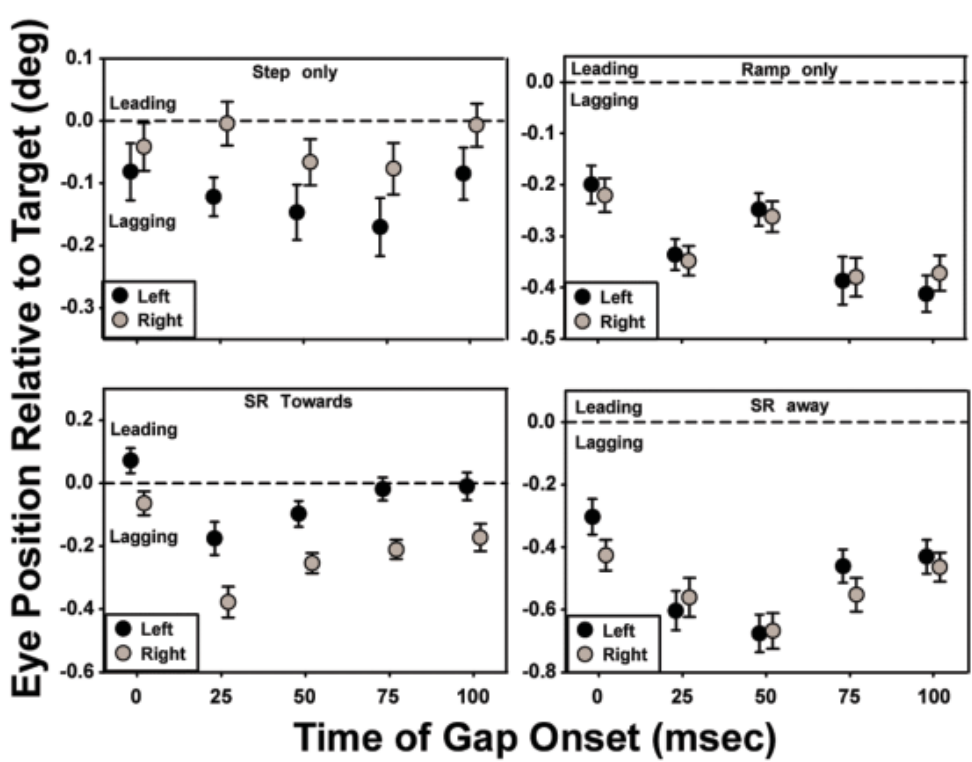
Figure 5 : The effect of a gap on saccade accuracy: the gap is most disruptive when it onsets at 25-50 ms after initiation of target